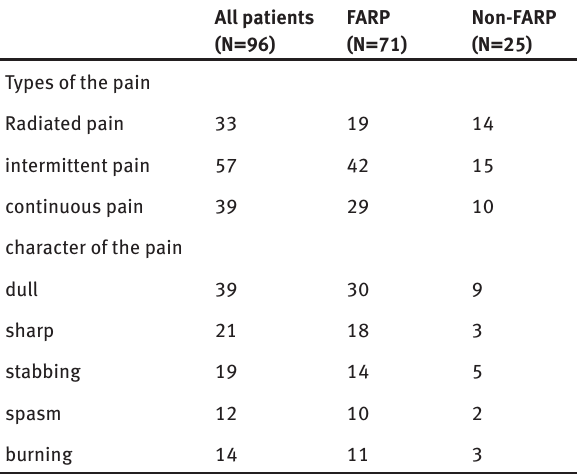
Table 1: Details of the anal pain.